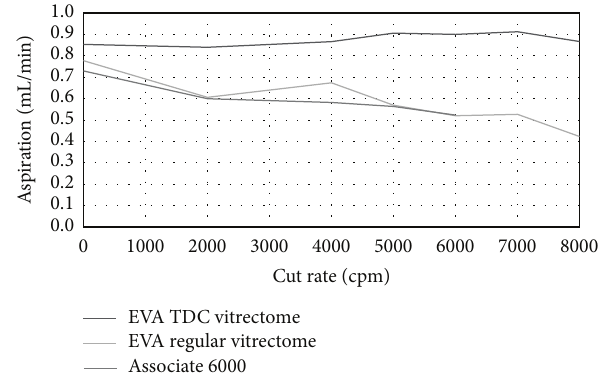
Figure 3: Aspiration flow rates of 27G TDC and standard vitrec- tomes @ 350–550 mmHg.